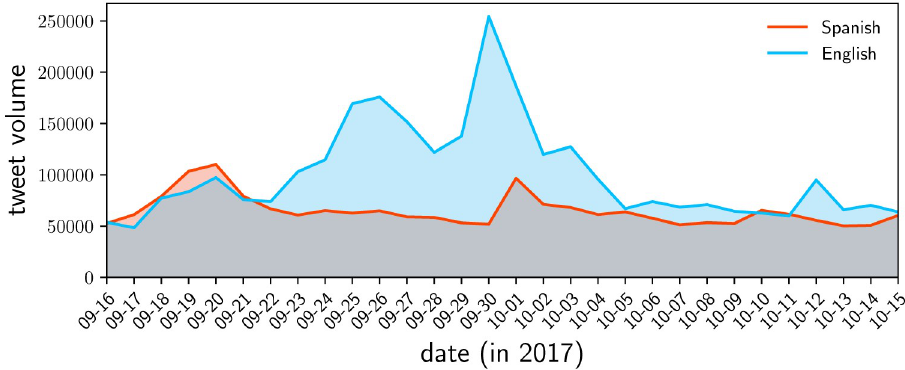
Fig 1. The daily volume of Spanish and English tweets concerning the hurricane or Puerto Rico in our collected subset of Twitter’s Decahose sample, roughly 10% of all public tweets.